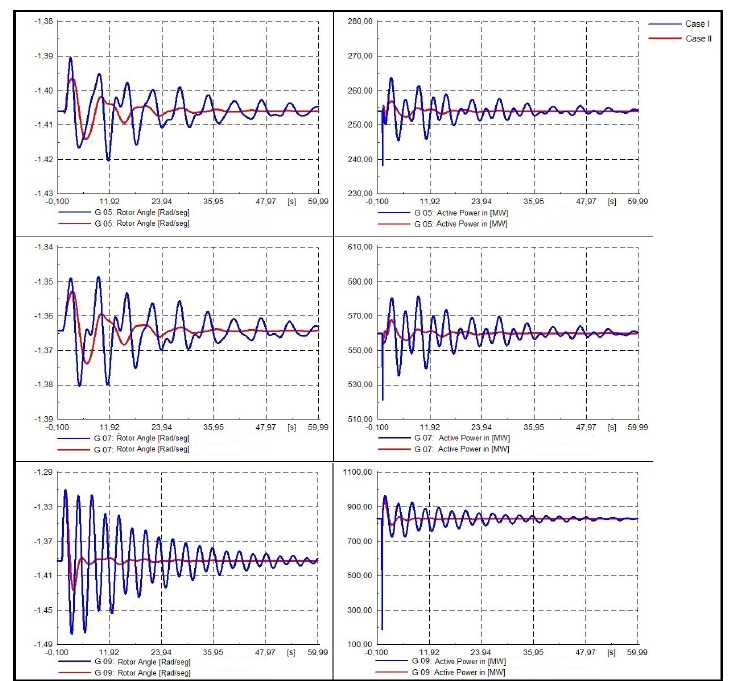
Figure 23. Rotor angle [rad] and Active Power [MW]-three phase fault at bus 29. 3. Three phase fault at bus 39.